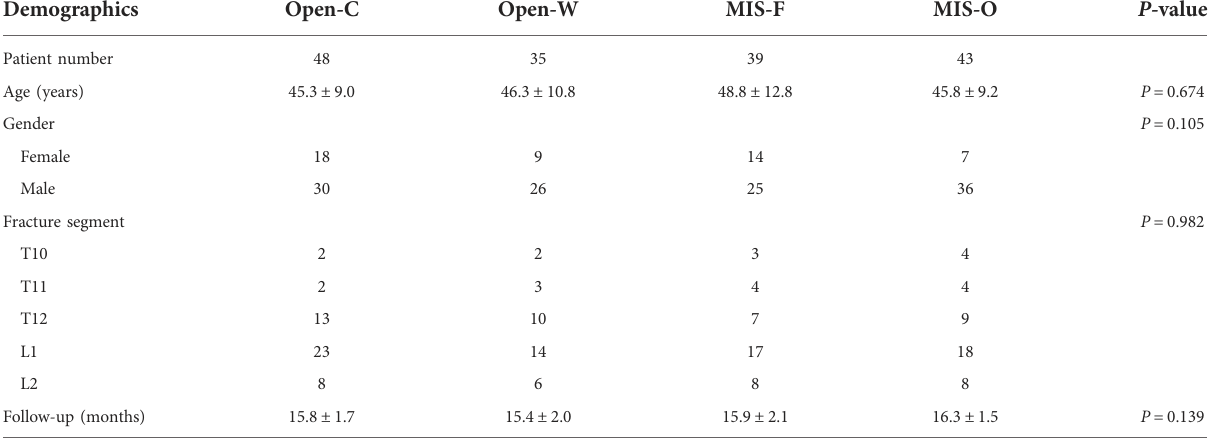
TABLE 1 Demographic data of the four groups.